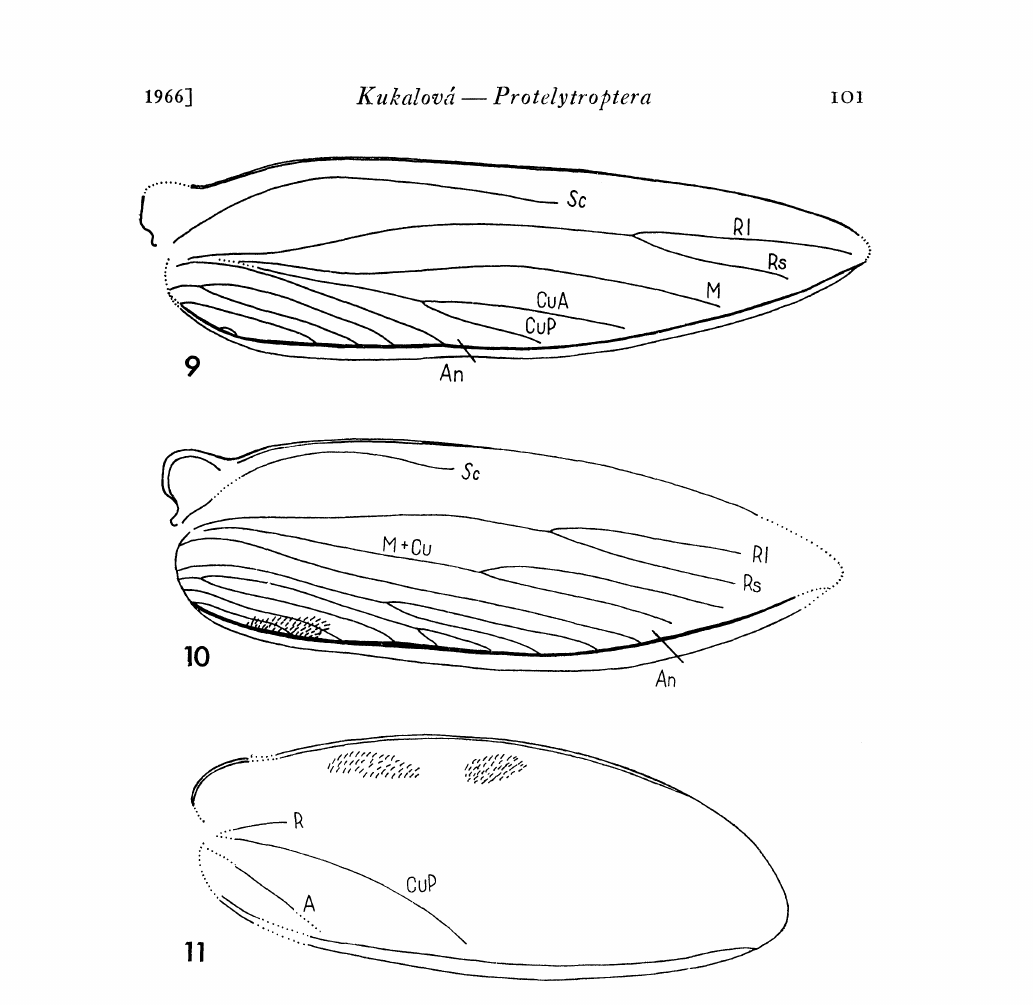
Text-figure 9. Stenelytron enerq;atum n. sp. Drawing of holotype, No. In 45958 (obverse) and In 45515 (reverse), Brit. Mus.; fore wing, Upper Permian, Australia (original). Text-figure 10. Xenclytron ligula n. sp. Drawing of holotype, No. In 45526, Brit. Mus.; fore wing, Upper Permian, Australia (original). Text-figure 11. Dermelytron conserati;um n. sp. Drawing of holotype, No. In 45725, Brit. Mus.; fore wing, Upper Permian, Australia